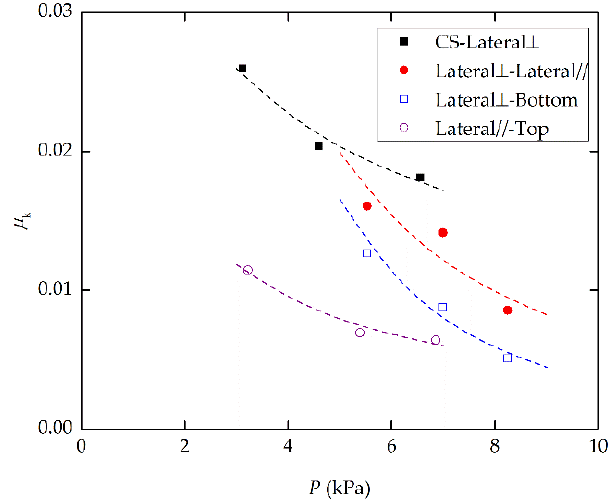
Figure 7. Variations of µ k with normal stress P for CS-Lateral ⊥ , Lateral ⊥ -Lateral//, Lateral ⊥ -Bottom, and Lateral//-Top. Also shown are the power-law regression lines (dashed lines).